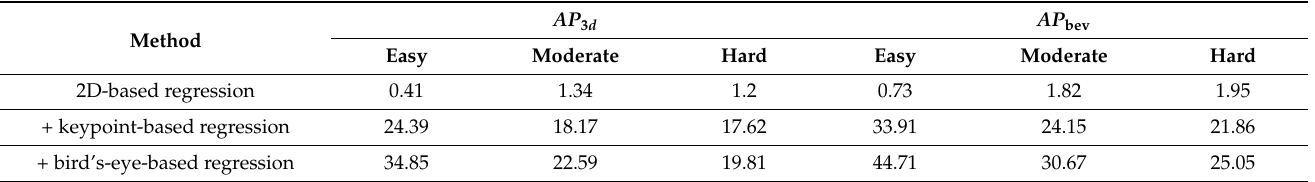
Table 4. Ablation study of 3D object